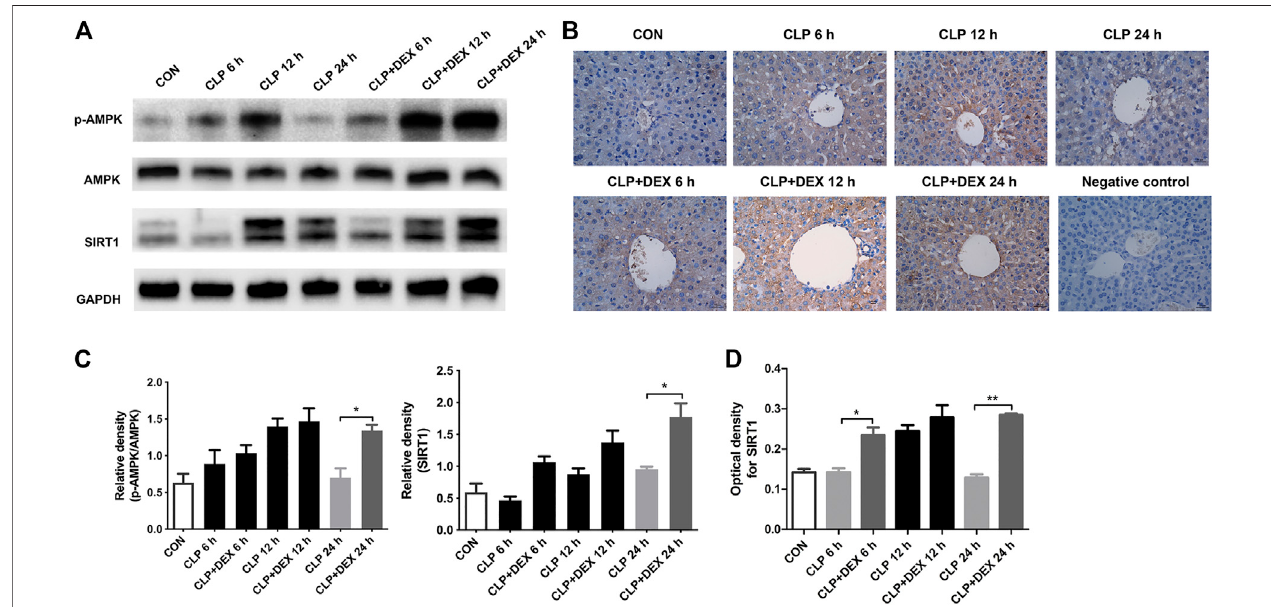
FIGURE5| EffectofDEXonAMPK/SIRT1pathwayactivation invivo . (A) TheproteinexpressionofAMPK, p -AMPK,andSIRT1inlivertissuesasdeterminedusing western blotting. (B) The SIRT1 translocation of each group was analyzed using immunohistochemistry (magni fi cation 400 × ). (C) Densitometric analysis of the related bands from (A) . (D) Analysis of the optical densities for SIRT1 from (B) . Error bars on the bar graphs represent the mean ± SD. * p < 0.05, ** p <